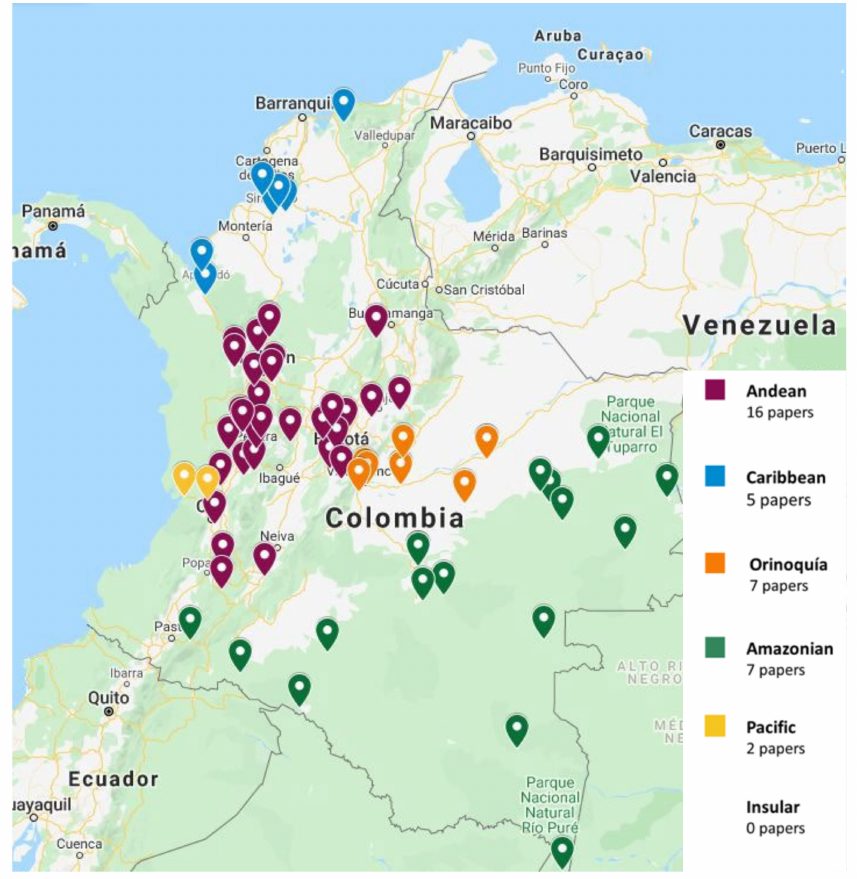
Figure 1. Distribution of the sampling sites of the selected papers across